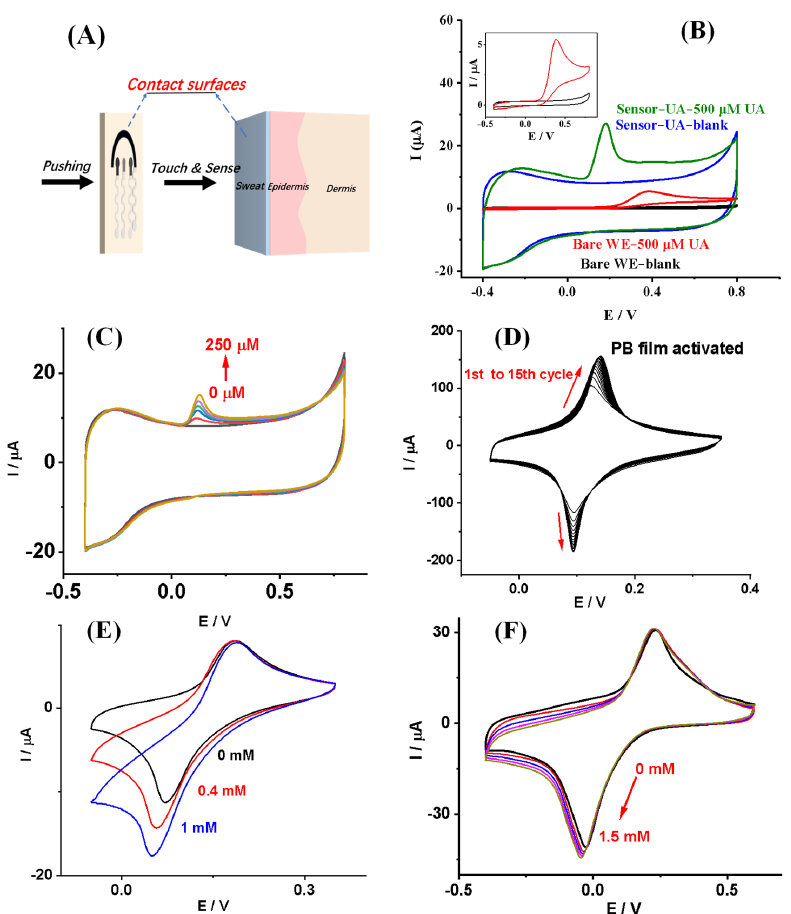
Figure 3. Electrochemical performance of the sensor. ( A ) Scheme of the working process of “Touch & Sense”. ( B ) CVs of the electrodes in PBS (blank) and PBS containing 500 µ M UA. The inset shows the CVs of unmodified carbon working electrode (bare WE) to blank and 500 µ M UA in PBS, respectively. Scan rate 50 mV/s, potential range − 0.4 V to 0.8 V. ( C ) CVs of Sensor-UA towards 0, 45, 100, 150, 200 and 250 µ M UA in PBS, respectively. Scan rate 50 mV/s, potential range − 0.4 V to 0.8 V. ( D ) CVs of PB film in 0.1 mM KCl and 0.1 mM HCl solution for activation. Scan rate 50 mV/s, potential range − 0.05 V to 0.35 V, 15 cycles. ( E ) CVs of PB modified carbon working electrode towards 0.1 M PBS + 0.1 M KCl containing 0, 0.4 and 1 mM H 2 O 2 , respectively. Scan rate 50 mV/s, potential range − 0.05 V to 0.35 V. ( F ) CVs of Sensor-glucose towards 0, 0.4, 0.8, 1.2, and 1.5 mM glucose in 0.1 M PBS, respectively. Scan rate 50 mV/s, potential range − 0.4 V to 0.6